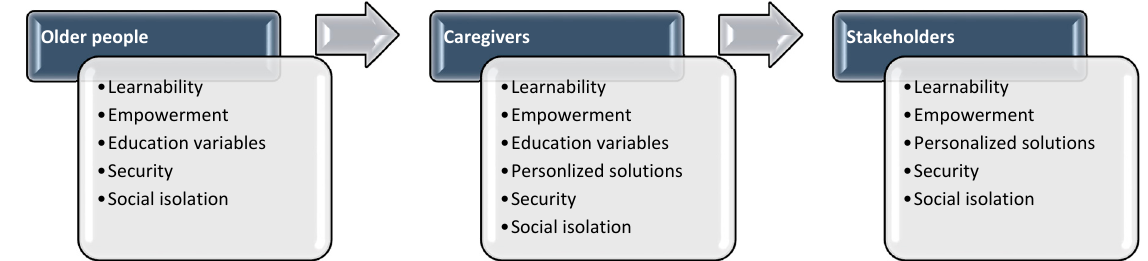
Figure 3. The six themes emerged from the thematic analysis in the three groups.